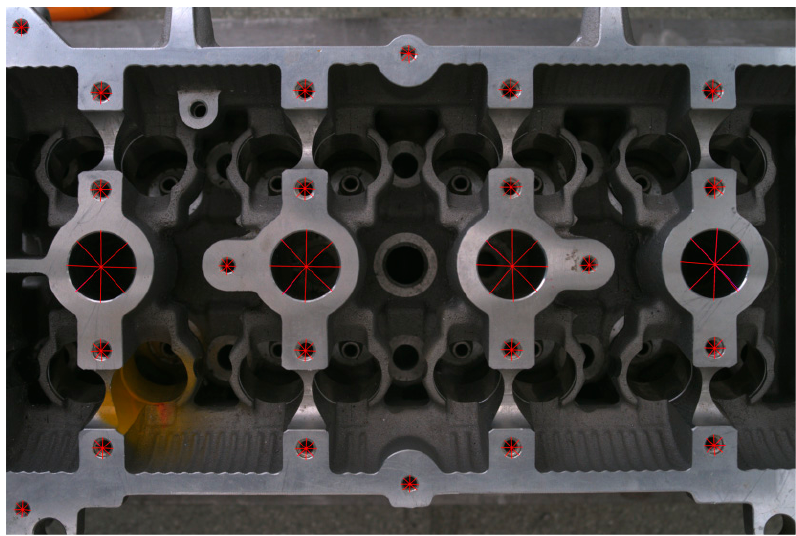
Figure 11. Matching results of the circular holes on the surface of engine cylinder head.